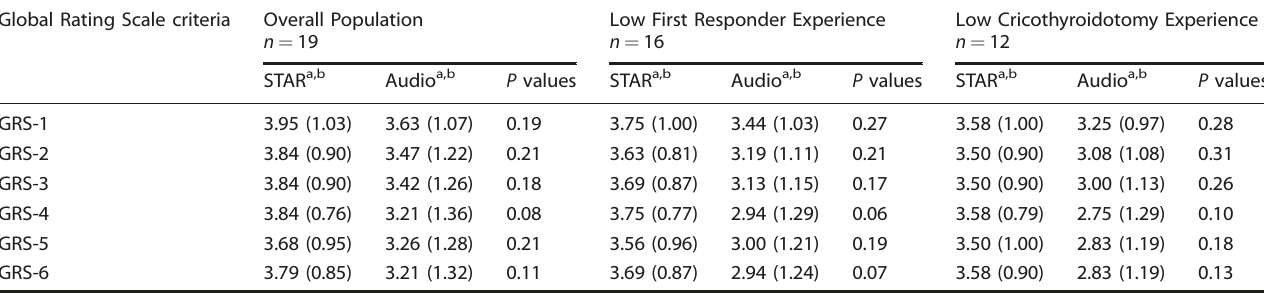
Table 3. Averaged results for the different criteria of the Global Rating Scale metric for the Overall Population and both the experience-based